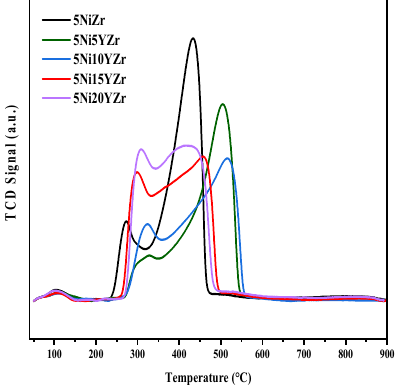
Figure 2. H 2 ‐ TPR profiles of the synthesized catalysts.